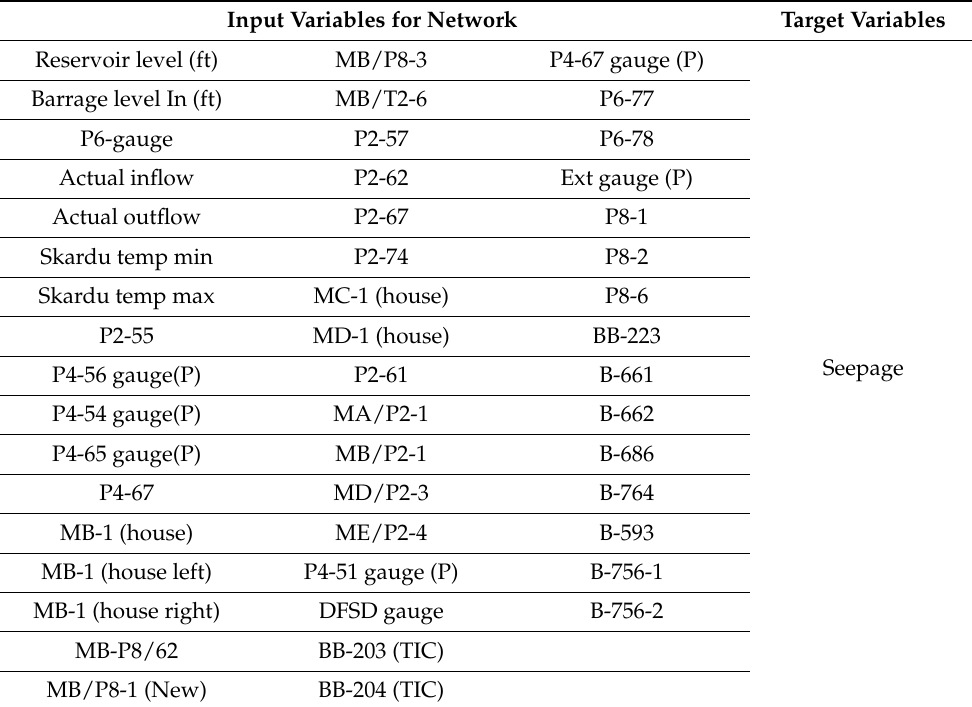
Figure 3. The research flow chart for model. Table 1. The input data for deep learning models.